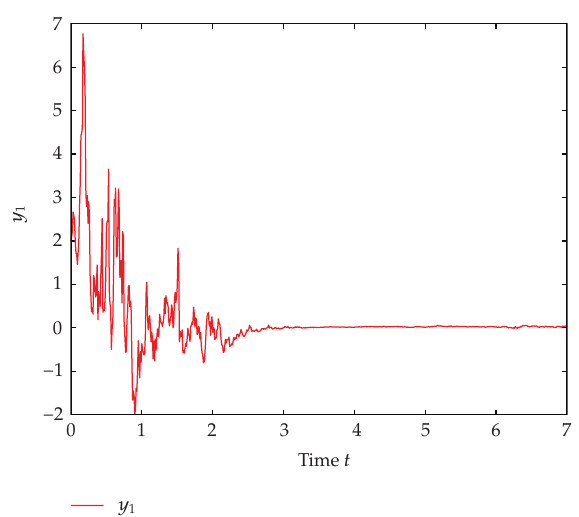
Figure 1: Numerical simulation for y 1 (cid:3) t (cid:4)